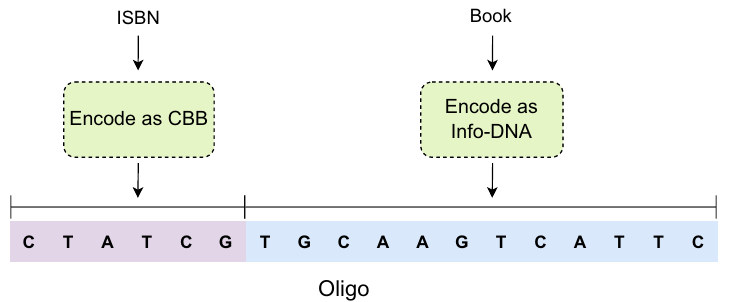
Figure 1. The composition of an oligo in our DNA storage